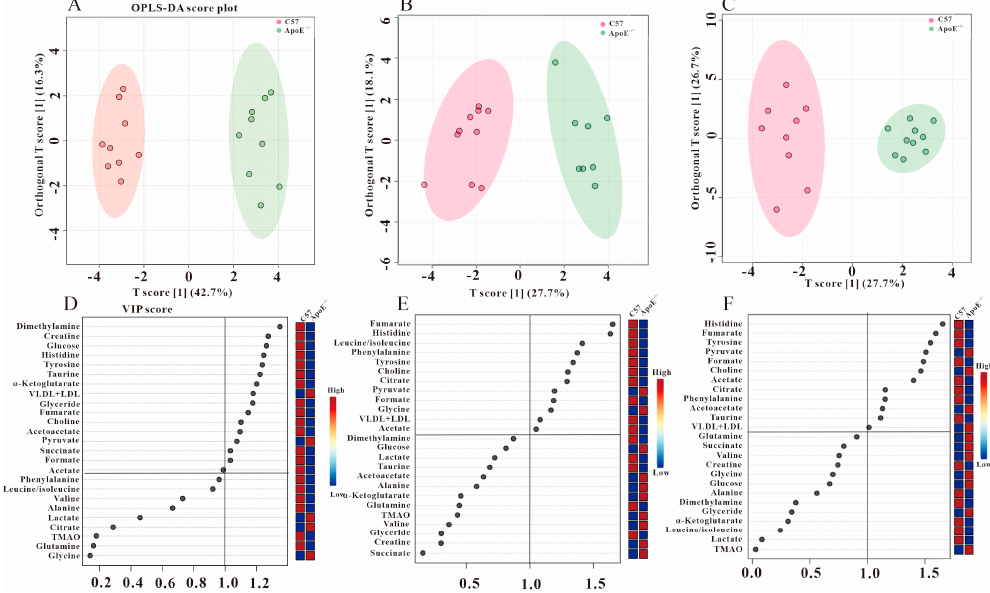
Figure 3. Metabolic differences between C57 and ApoE − / − groups at three periods. OPLS − DA scores plots ( A ) (8 w), ( B ) (8 + 4 w), ( C ) (8 + 8 w) and VIP scores ( D ) (8 w), ( E ) (8 + 4 w), ( F ) (8 + 8 w).